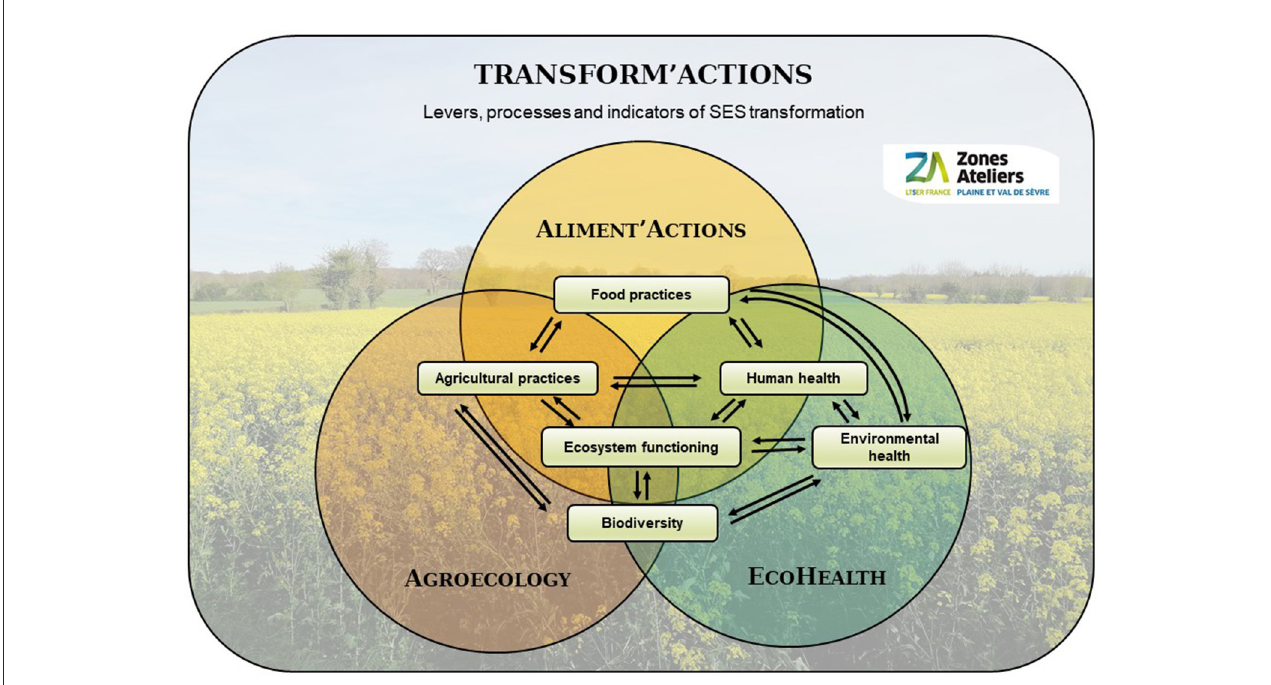
FIGURE1 Position of the Aliment’Actions project within